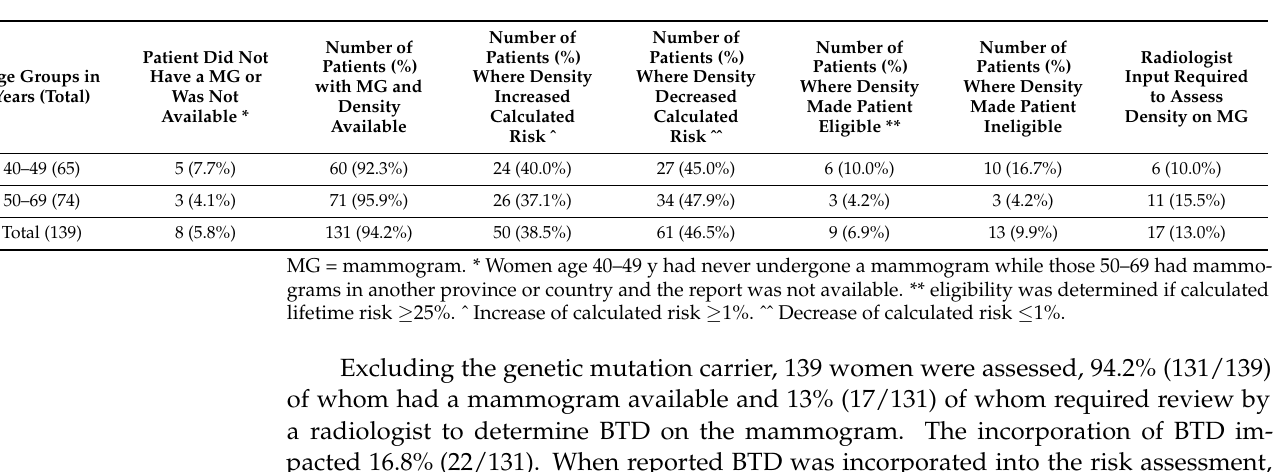
Table 1. The impact on risk assessment and determination of clinical eligibility on addition of breast tissue density according to age groups 40 – 49 and 50 – 69.